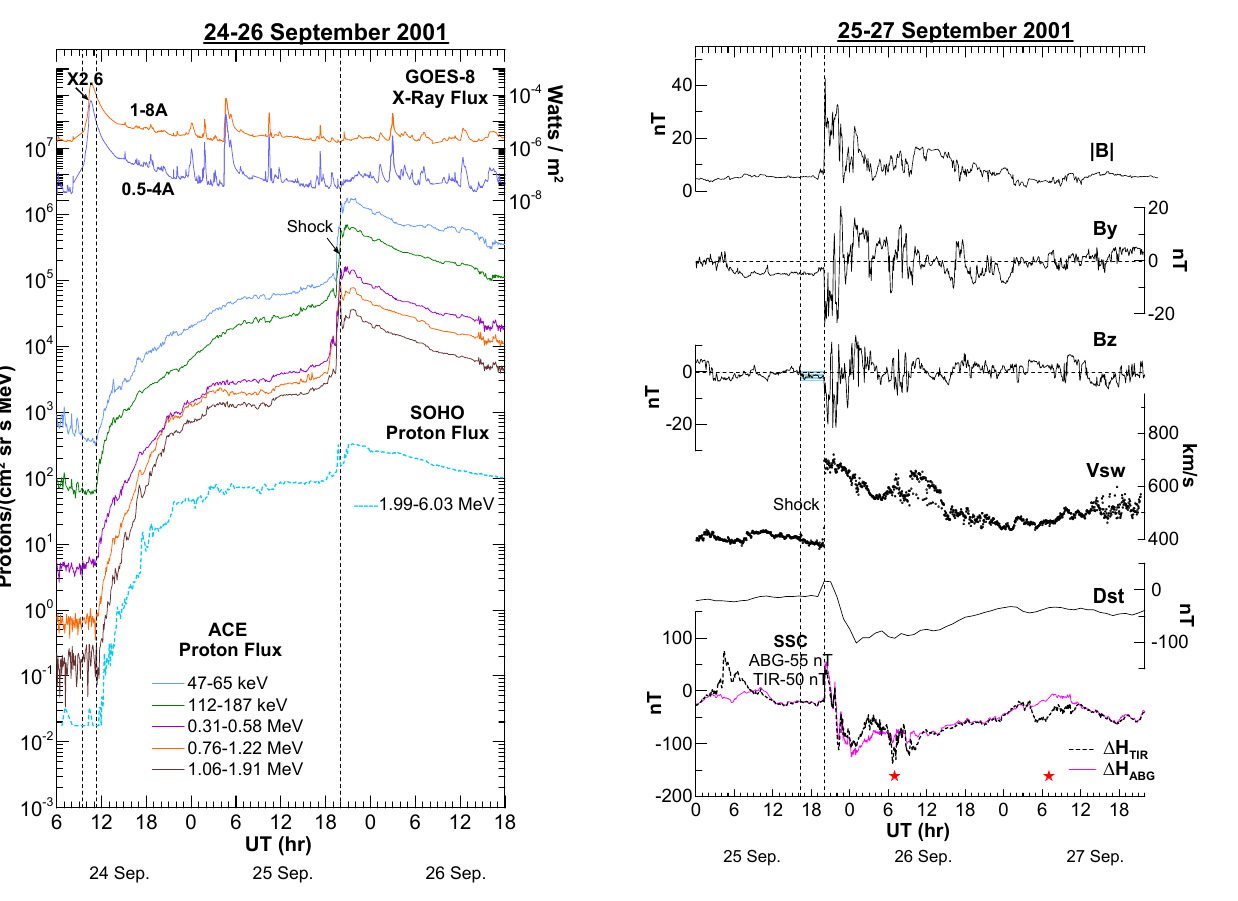
Fig. 7. Upper panel shows X-ray flux at two wavelengths 0.5–4 ˚A and 1–8 ˚A. Proton flux characteristics in various energy lev- els of 47–65keV, 112–187keV, 0.31–0.58MeV, 0.76–1.22MeV and 1.06–1.91MeV (ACE) and 1.99–6.03MeV (SOHO) for 24–26 September 2001 are shown in lower panel.